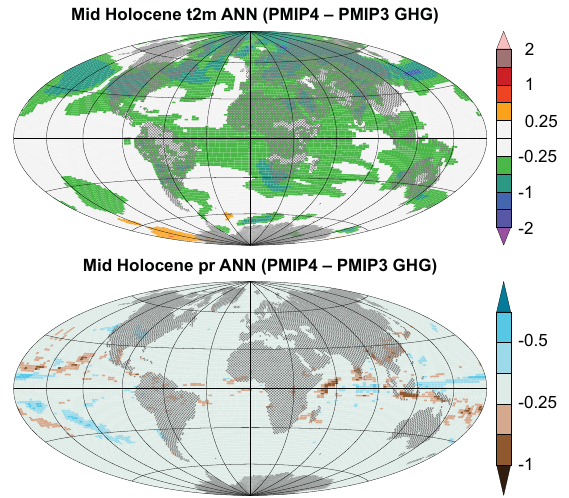
Figure 5. Impact of the changes in trace gases specified for 6ka between PMIP3 and PMIP4 on surface air temperature ( ◦ C) and precipitation (mmd − 1 ) as estimated with the IPSLCM5A model. Only significant values are plotted in